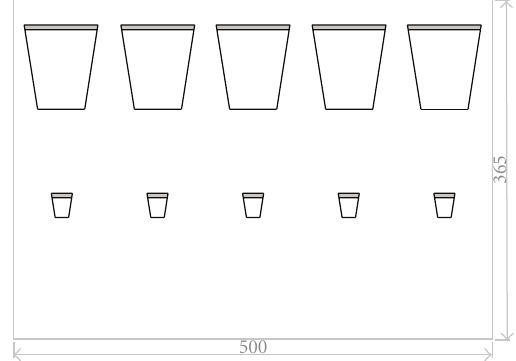
Figure 25: Mitre joint cutting template for 300 mm tall, 100 mm unit-square base, pyramidal RAM (must be scaled to indicated dimensions prior to use).